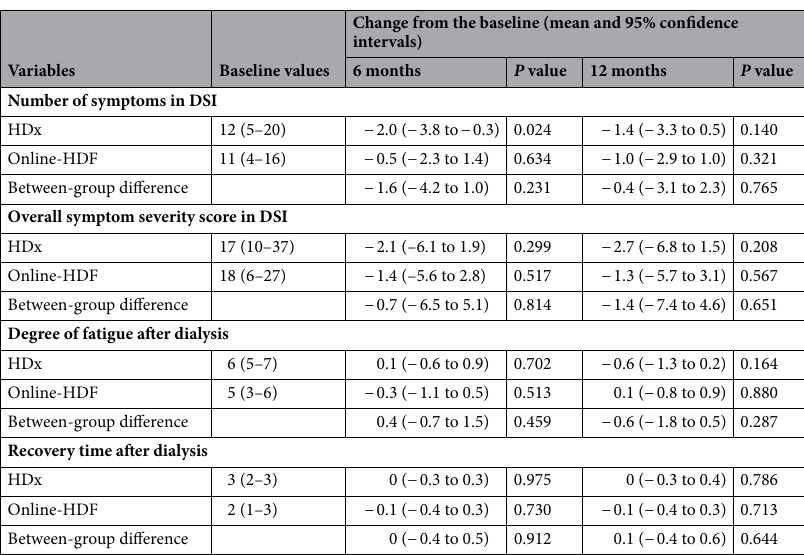
Table 4. Linear mixed-effects model for the change in patient-reported outcomes. DSI dialysis symptom index, HDx expanded hemodialysis, HDF